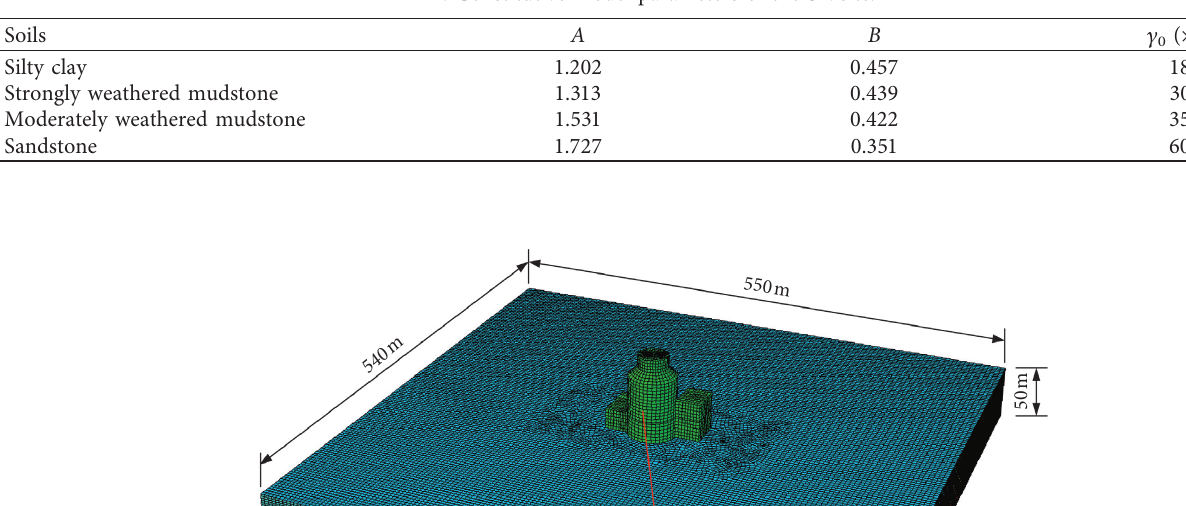
Table 4: Constitutive model parameters of the SR site.